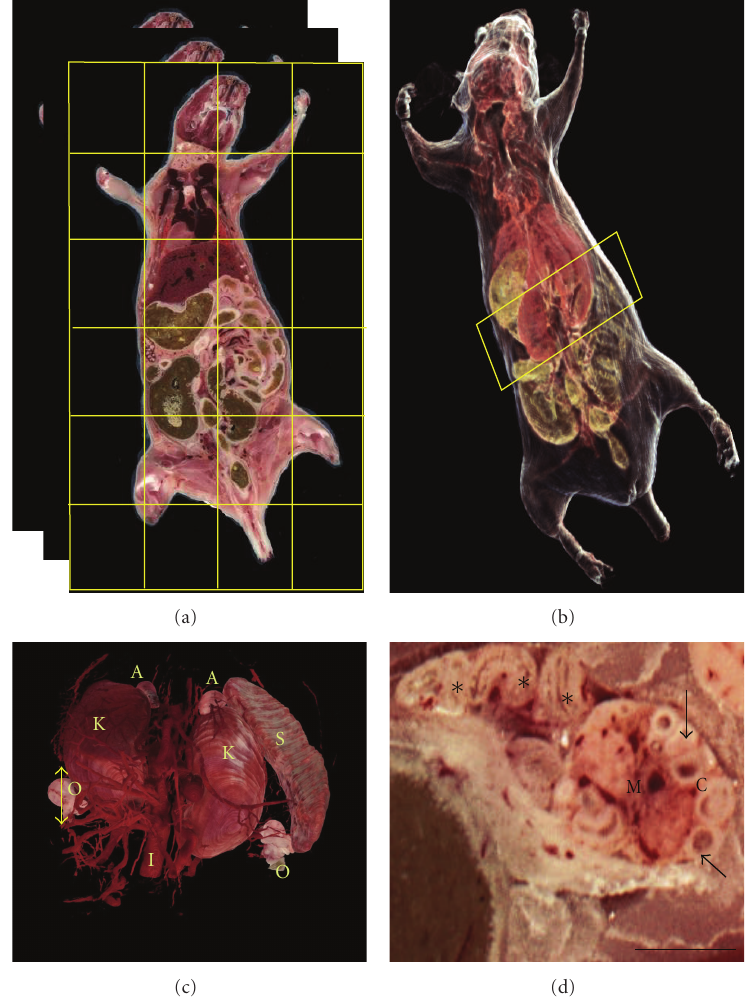
Figure 1: Multiscale Visualization. (a) A 421-day-old female PEPCK-C mus mouse was cryo-imaged at very high-resolution by automatically tiling across the block-face and sectioning serially. (b) The 2D stitched images were converted into a 3D volume > 60GB and visualized in low-resolution through automatic enhanced volume visualization schemes. Interactively, regions were then chosen (box) to visualize in higher-resolution. (c) From the chosen region, a higher-resolution rendering shows the kidneys (K), the adrenal glands (A) above the kidneys, the spleen (S), the inferior vena cava (I), and the pair of ovaries (O). Note that all renderings are in true color. Sections were then chosen (double-arrow line) to investigate structures in full resolution. (d) Coronal section through the left ovary (section 280). The medulla region (M) consists of loose connective tissue and large blood vessels while the peripheral cortex region (C) contains a number of ovarian follicles (arrows) in di ff erent stages of development. Sections through several fimbriae ( ∗ ) of the infundibulum of the uterine tube can be seen to the left of the ovary (Bar = 1mm).